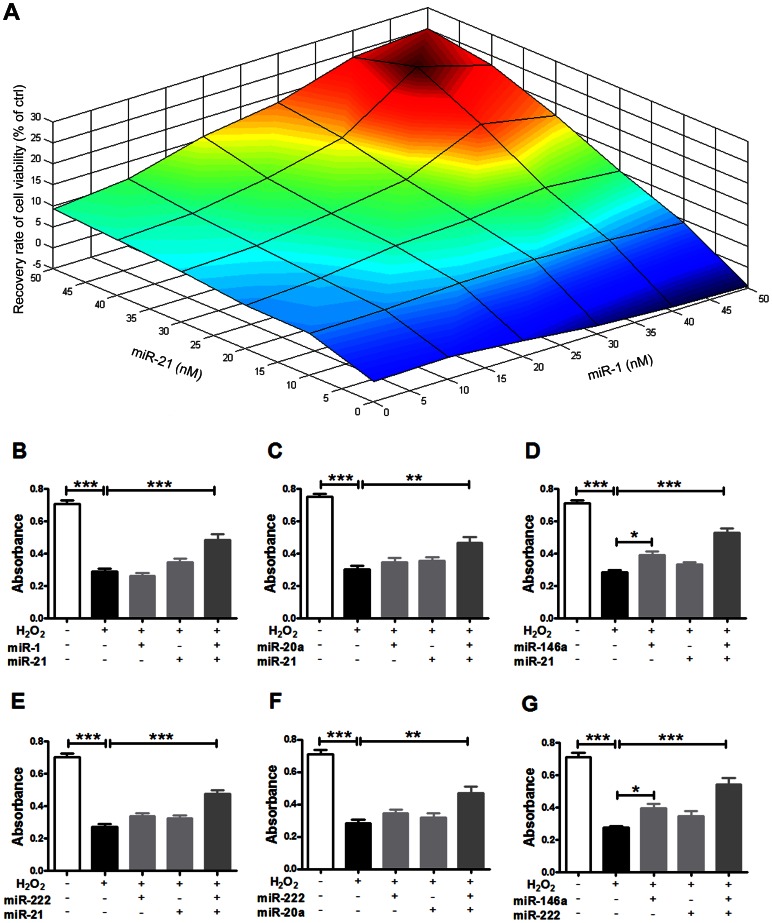
Synergisitic anti-apoptotic properties of miRNA pairs against H2O2-induced myocardial cell injury.A. Heatmap of recovery rate of cell viability at different transfection concentration ratios of miR-1 and miR-21. Recovery rate of cell viability is calculated as the difference between the mean absorbance values of miRNA transfection group and H2O2 treatment group divided by that of control group (expressed in percentage); n = 5. B. Results of MTT assay of the miRNA pair miR-1:miR-21 (40 nM). ***p<0.001 ctrl vs H2O2 treatment group; ***p<0.001 miR-1 and miR-21 co-transfection group vs H2O2 treatment group; n = 5. C. Results of MTT assay of the miRNA pair miR-20a:miR-21 (40 nM). **p<0.01, ***p<0.001 vs H2O2 treatment group; n = 5. D. Results of MTT assay of the miRNA pair miR-21:miR-146a. *p<0.05, miR-146a transfection group vs H2O2 treatment group; ***p<0.001 ctrl vs H2O2 treatment group; ***p<0.001 miR-21 and miR-146a co-transfection group vs H2O2 treatment group; n = 5. E. Results of MTT assay of the miRNA pair miR-21:miR-222 (40 nM). ***p<0.001 ctrl vs H2O2 treatment group; ***p<0.001 miR-21 and miR-222 co-transfection group vs H2O2 treatment group; n = 5. F. Results of MTT assay of the miRNA pair miR-20a:miR-222 (40 nM). **p<0.01, ***p<0.001 vs H2O2 treatment group; n = 5. G. Results of MTT assay of the miRNA pair miR-146a:miR-222. *p<0.05, miR-146a transfection group vs H2O2 treatment group; ***p<0.001 ctrl vs H2O2 treatment group; ***p<0.001 miR-146a and miR-222 co-transfection group vs H2O2 treatment group; n = 5.